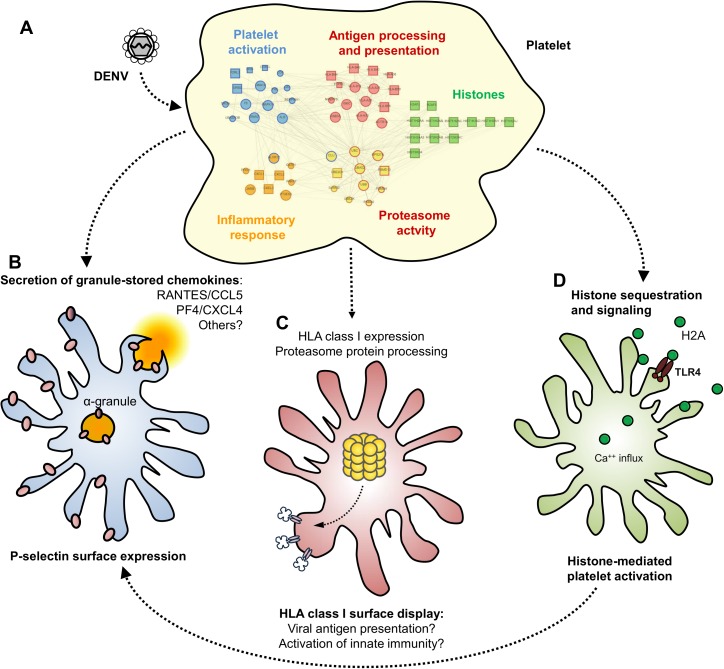
Schematic representation of proteome changes in platelets from dengue-infected patients.(A) Platelets from dengue-infected patients exhibit changes in their proteome, phenotype and function. Alterations in the platelet proteome in dengue appear to influence five main biological processes based on our analysis: (i) platelet activation; (ii) antigen processing and presentation; (iii) processes influenced by proteasome dependent protein catabolism; (iv) inflammatory response and; (v) histone expression and signaling. (B) DENV infection activates platelets triggering granule release of stored chemokines (i.e. PF4/CXCL4 and RANTES/CCL5) and P-selectin surface expression. (C) DENV also increases HLA class I protein expression and its surface presentation through mechanisms requiring proteasome protein processing. The nature of peptides processed by proteasome activity and presented in HLA class I remains unknown. (D) Platelets sequester circulating cell-free histone H2A from plasma, which contributes to platelet activation during dengue infection.